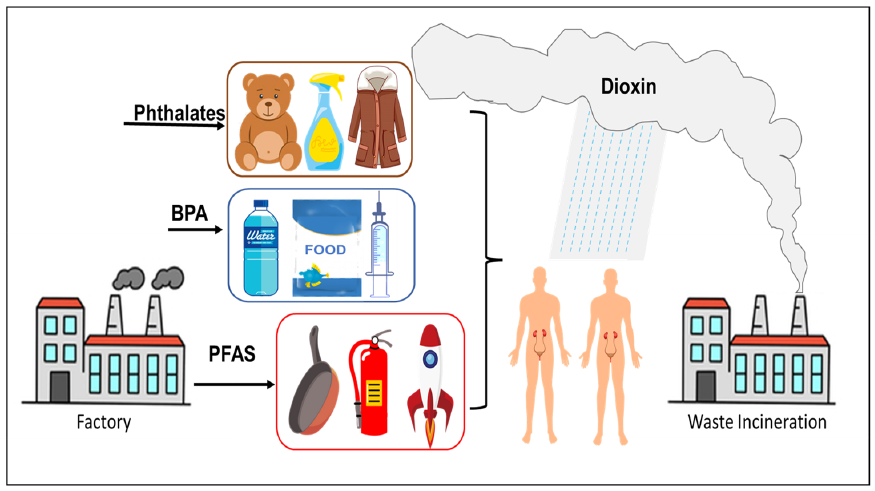
Figure 1. Common sources of EDCs.